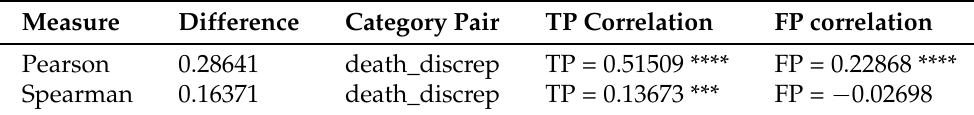
Table 22. Death and Discrepancy in High.